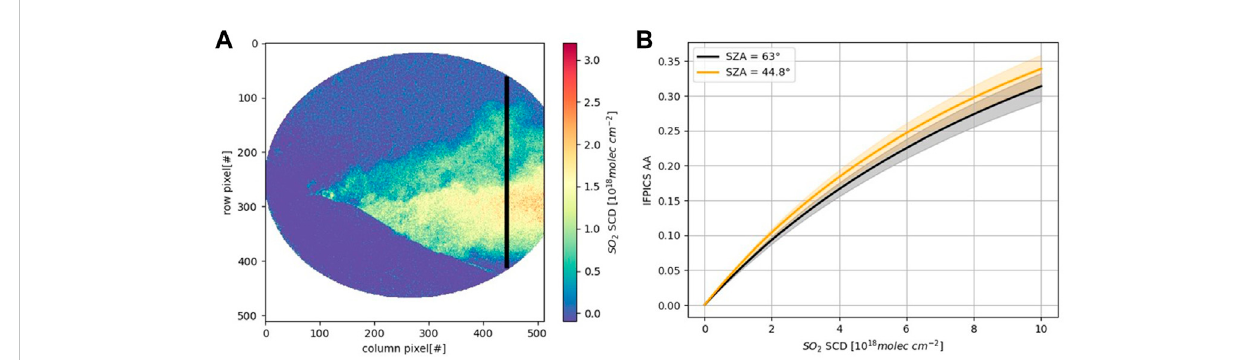
FIGURE 5 (A) SO 2 IFPICS image acquired at the 15th of July at the mountain ridge “ Schiena dell ’ Asino ” in an approximate distance of 5.3 km to the crater area. The image has a spatial resolution of 400 × 400 pixels and a time resolution of 2.4 s. The vertical black line shows the line of integration for the SO 2 fl ux calculation. (B) Exemplarymodelcalibrationcurves oftheSO 2 IFPICSinstrument.The shadedareamarksthemodel error. The blackcurvemarksthe fi rst calibration (SZA = 63 ° ) for the measurement time series and the orange curve the last one (SZA = 44.8 ° ). In between the calibration curve is dynamically adapted according to the SZA.